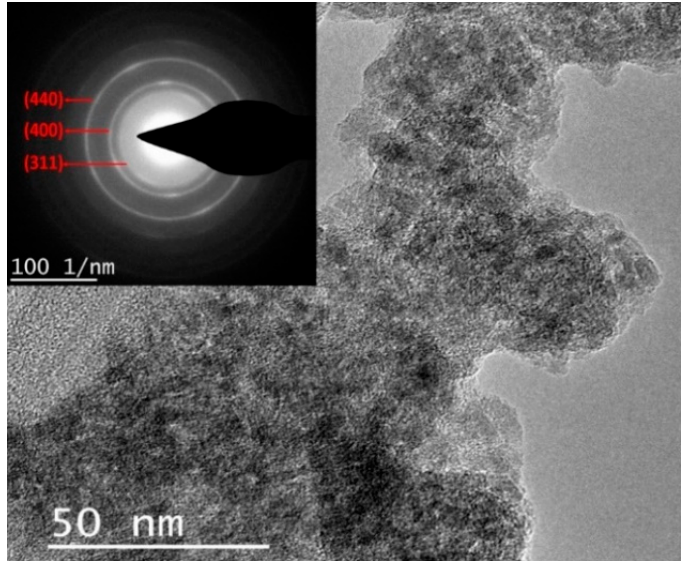
Figure 5. Morphological analysis by TEM and electron diffraction pattern from the experimental Morphological analysis by TEM and electron di ff raction pattern from the alumina. experimental